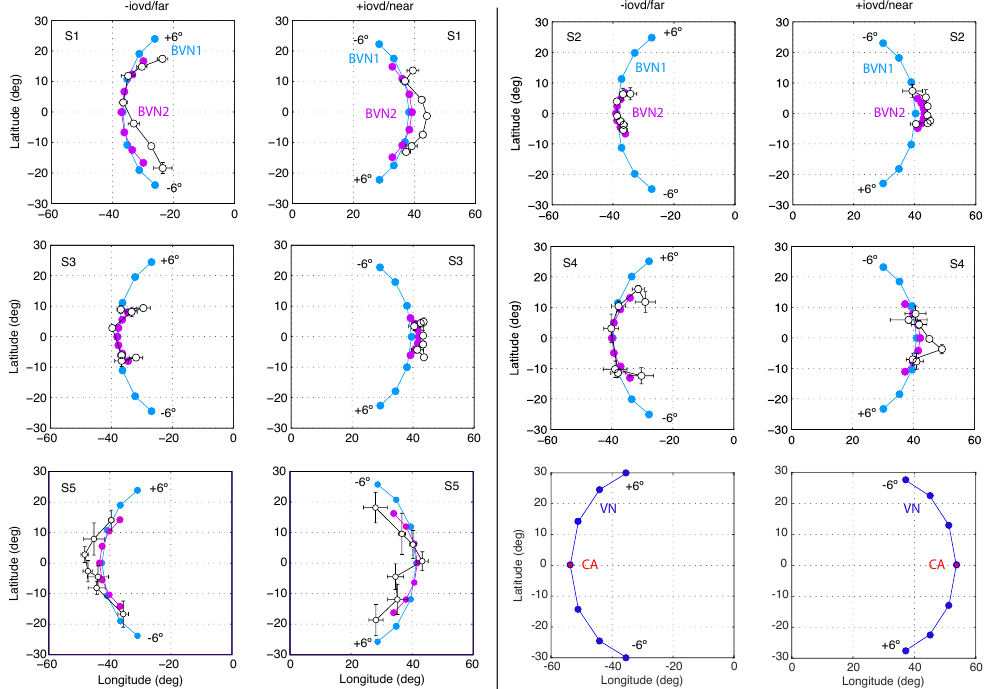
Figure 6. Motion directions in Experiment 1. In two columns pairs of graphs are shown for Observer S1 to S5 with − IOVD/far on the left +IOVD/near on the right. In each graph latitude is plotted against longitude angles. Circles connected by a line indicate motion directions for the seven line stimuli slanted in depth from vertical with orientation difference − 6 ◦ to + 6 ◦ in steps of 2 ◦ . Black open circles represent observed longitude and latitude angles, averaged across repeated trials. Horizontal and vertical error bars denote ± 1 SEM. Light blue and light purple circles denote motion direction estimates of the best-fitting BVN1 and BVN2 model, respectively. The last pair illustrates geometric predictions of VN (blue circles) and CA (red